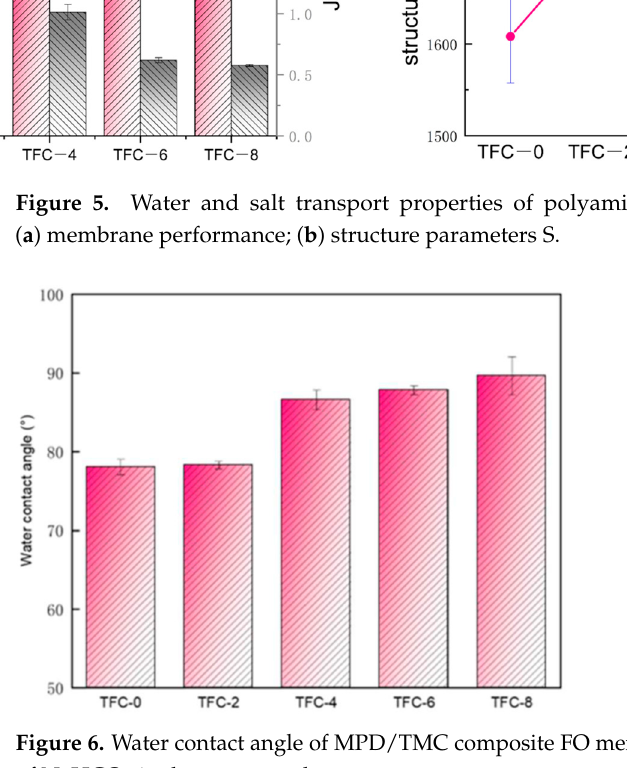
Figure 6. Water contact angle of MPD/TMC composite FO membranes with different concentra- tions of NaHCO 3 in the aqueous phase. of NaHCO 3 in the aqueous